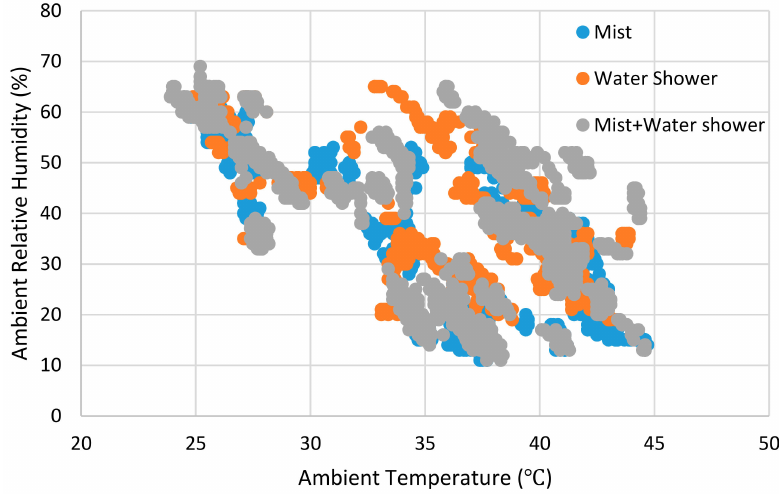
Figure 3. Distribution of ambient temperature and relative humidity during the data-collection